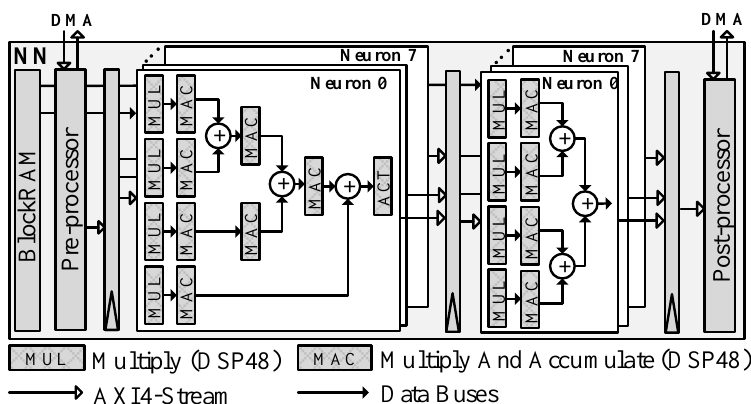
Figure 4. The generated FPGA block architecture using the HLS implementation approach.